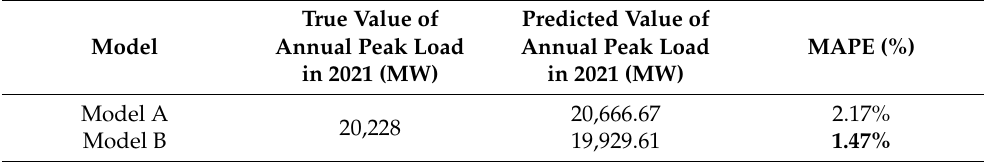
Table 6. Comparison of the proposed model with or without using the designed